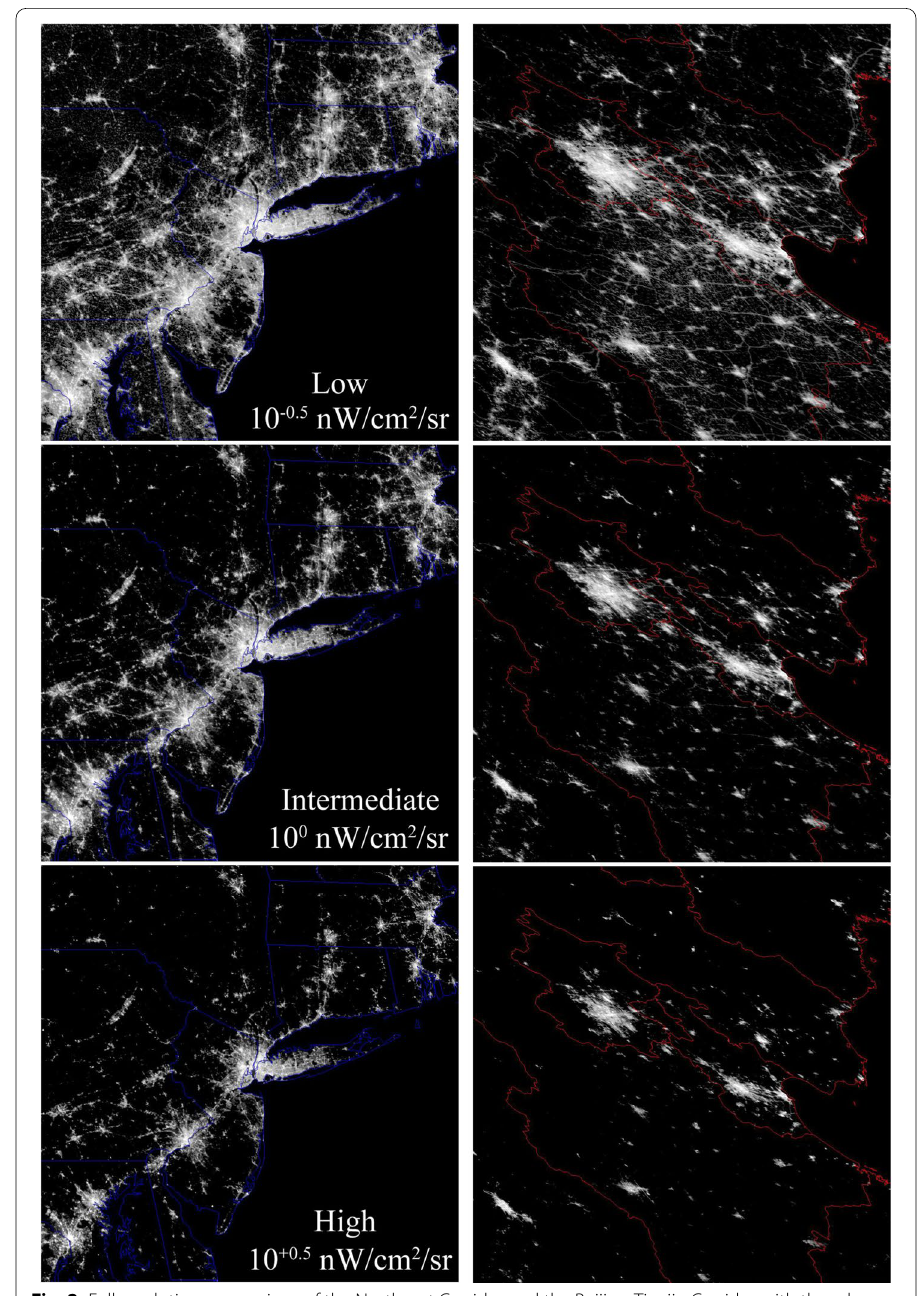
Fig. 2 Full resolution comparison of the Northeast Corridor and the Beijing-Tianjin Corridor with three low luminance thresholds. Increasing the threshold attenuates dimmer light pixels at the periphery of network components. The result is to reduce the number, size and connectivity of all components in the network. Luminance scale same as Fig. 1. Enlarge to see full resolution